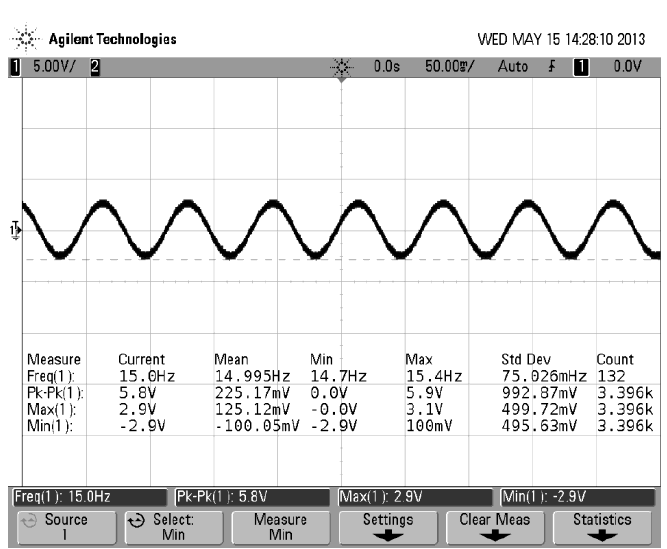
Figure 7. Experimental